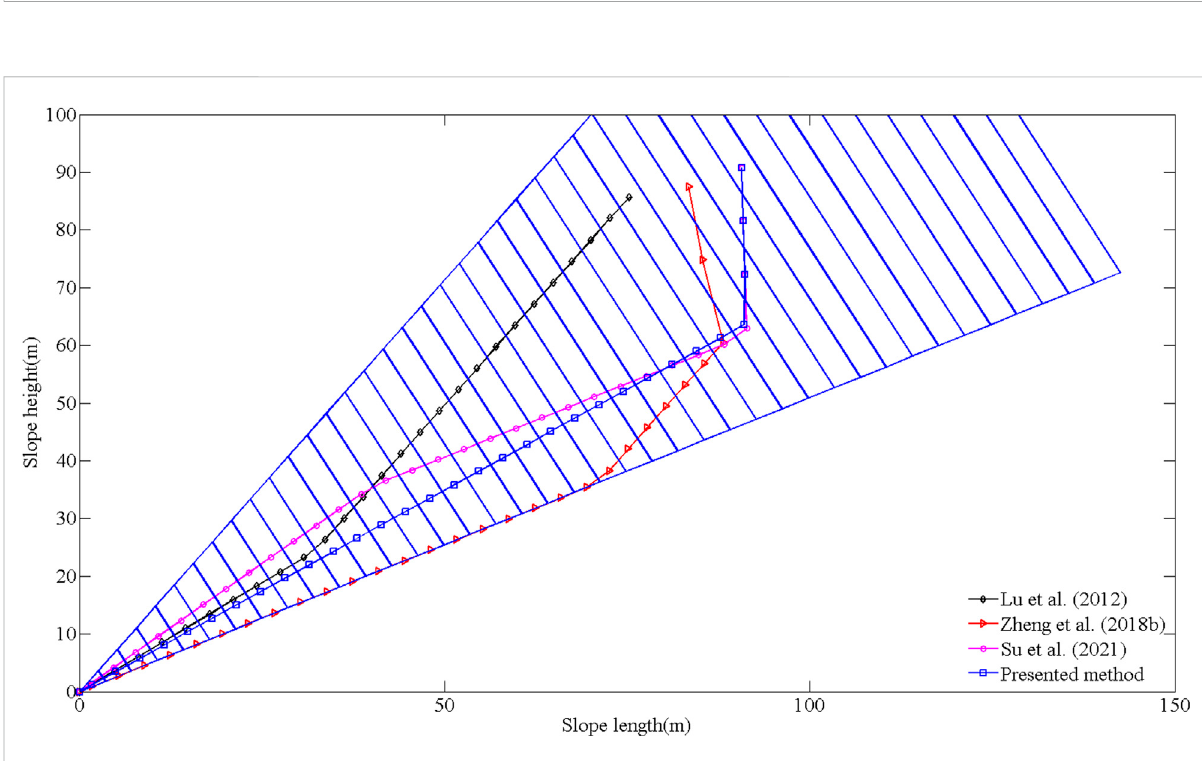
FIGURE 16 The failure surfaces of Yangtai slope obtained using different